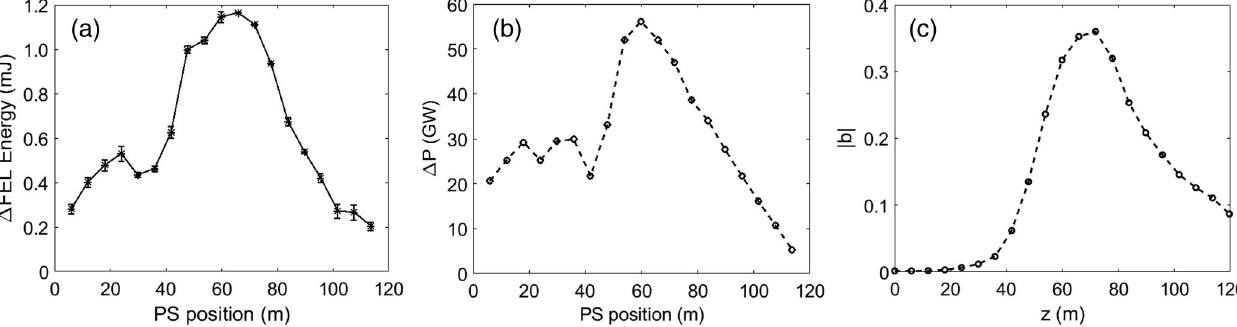
FIG. 7. The difference of maximum and minimum FEL energy from (a) experiment and (b) simulation according to the position of the phase shifter for scanning the gap. (c) Bunching factor along the undulator line obtained from simulation.